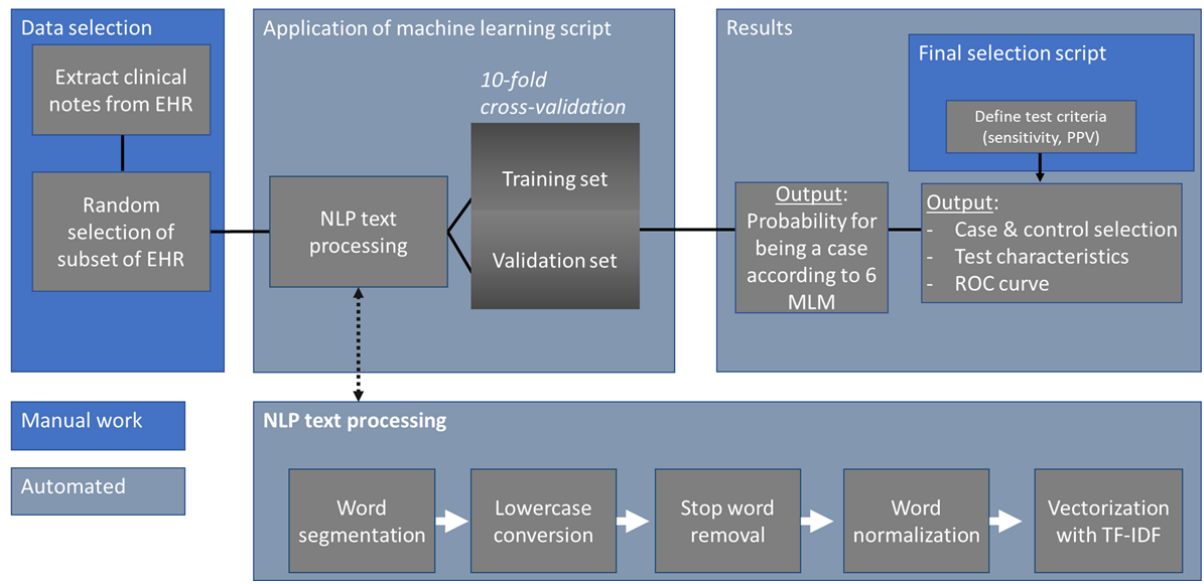
Figure 6. Flowchart describing the steps to apply the machine learning scripts to new data. EHR: electronic health record; MLM: machine learning method; NLP: natural language processing; PPV: positive predictive value; ROC: receiver operating characteristic; TF-IDF: term frequency by inverse document